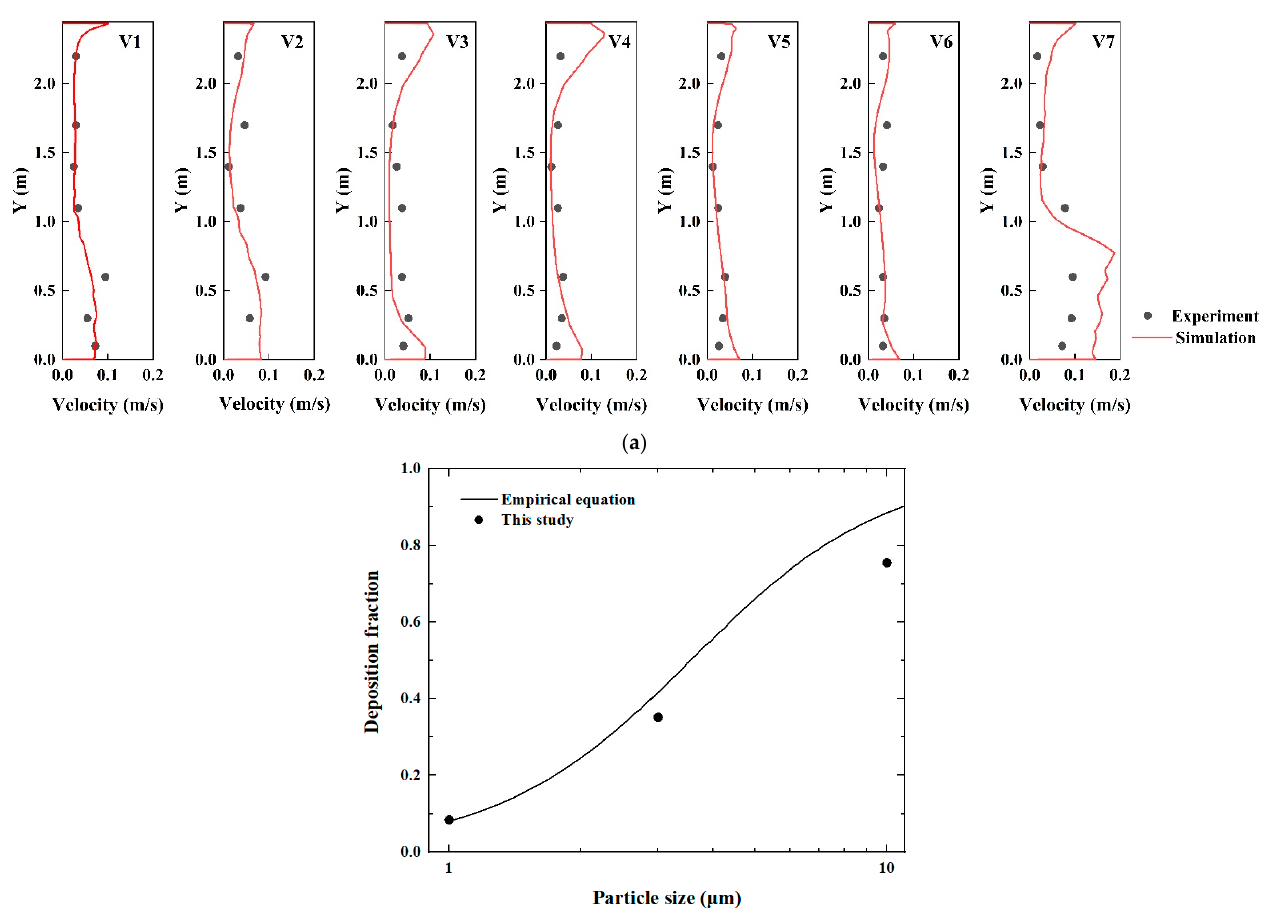
Figure 5. Comparison of experimental data and numerical calculation results in terms of ( a ) velocity and ( b ) particle deposition fraction.